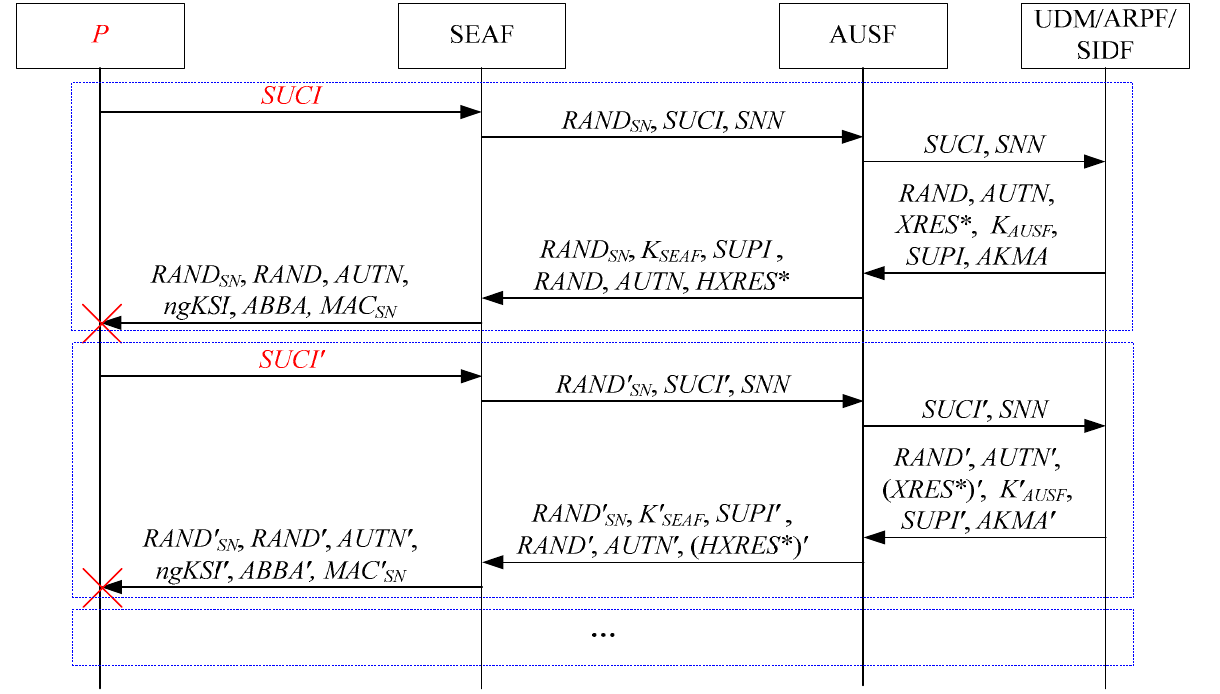
Information 2022 , 13 , 257 Figure 3. DoS attacks against both the SN and the HN for the 5G-IPAKA protocol.